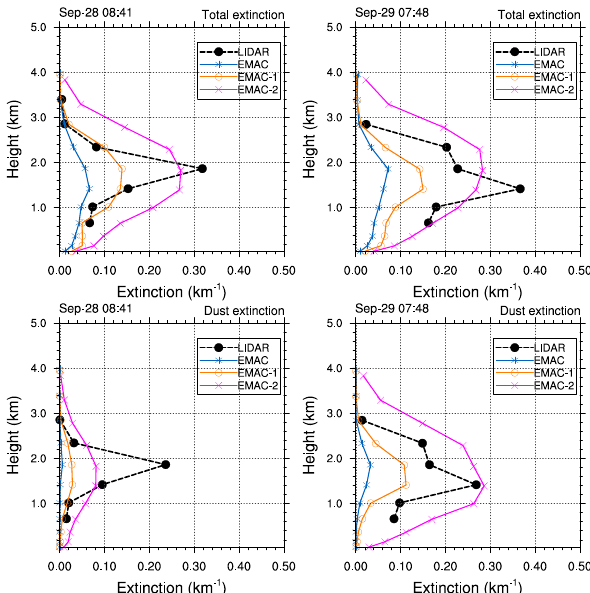
Figure 3: Comparison between the modeled and the observed total and dust only extinction Figure 10. Comparison between the modeled and the observed total at CUT-TEPAK station at di↵erent longitudes: 33  E (EMAC) at CUT-TEPAK station, 34  E and dust only extinction coefficient at CUT-TEPAK lidar station at (EMAC-1) and 35  E (EMAC-2); all refer to the latitude of CUT-TEPAK (34.675  N). different longitudes: 33 ◦ E (EMAC) at CUT-TEPAK station, 34 ◦ E (EMAC-1) and 35 ◦ E (EMAC-2); all longitudes refer to the latitude of CUT-TEPAK (34.675 ◦